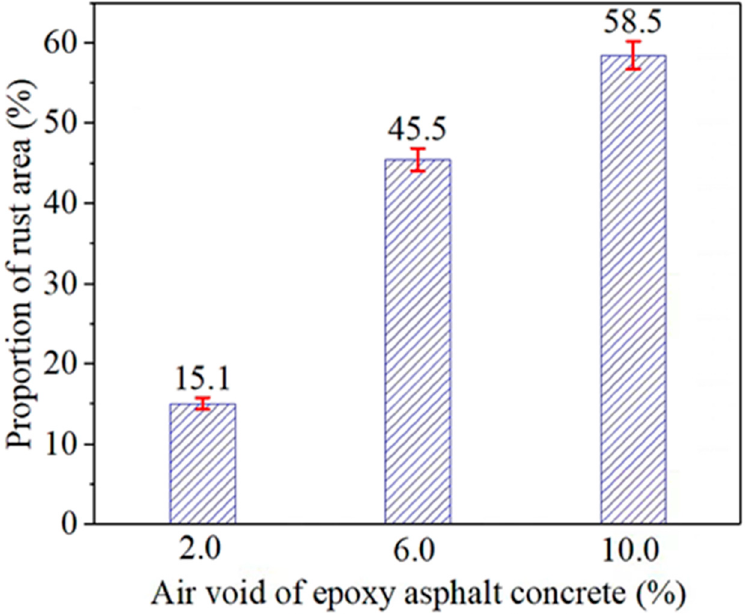
Figure 21. Influence of the pavement concrete air void on the corrosion of the steel plate of the composite structure specimen.